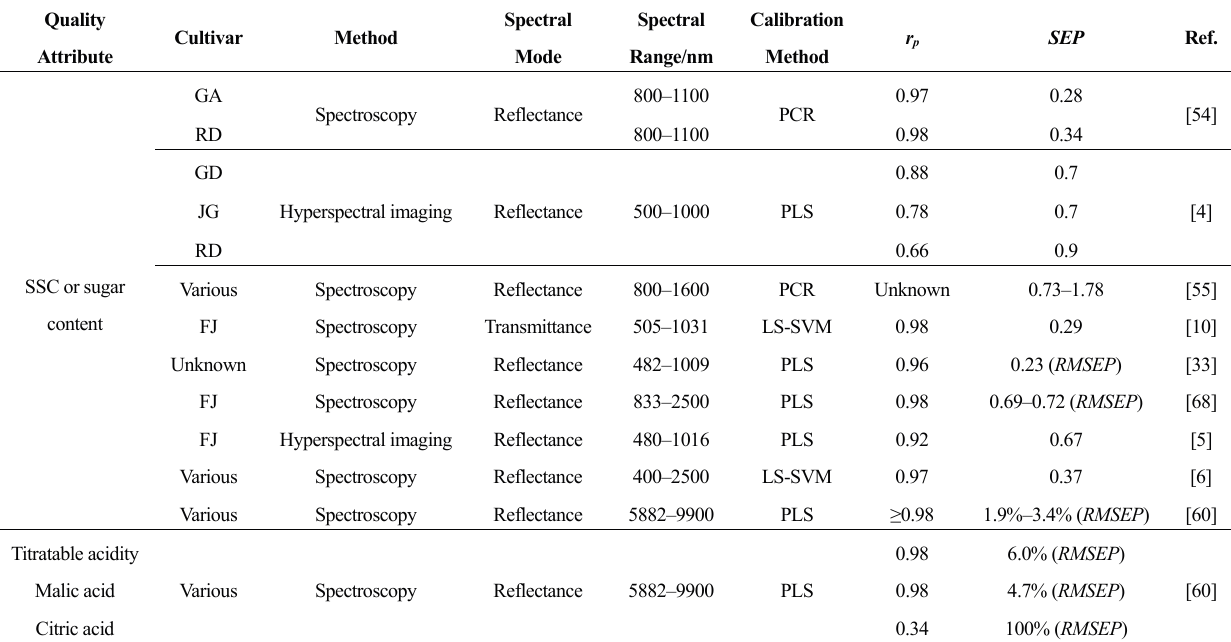
Table 2. Overview of the applications for measuring quality attributes in